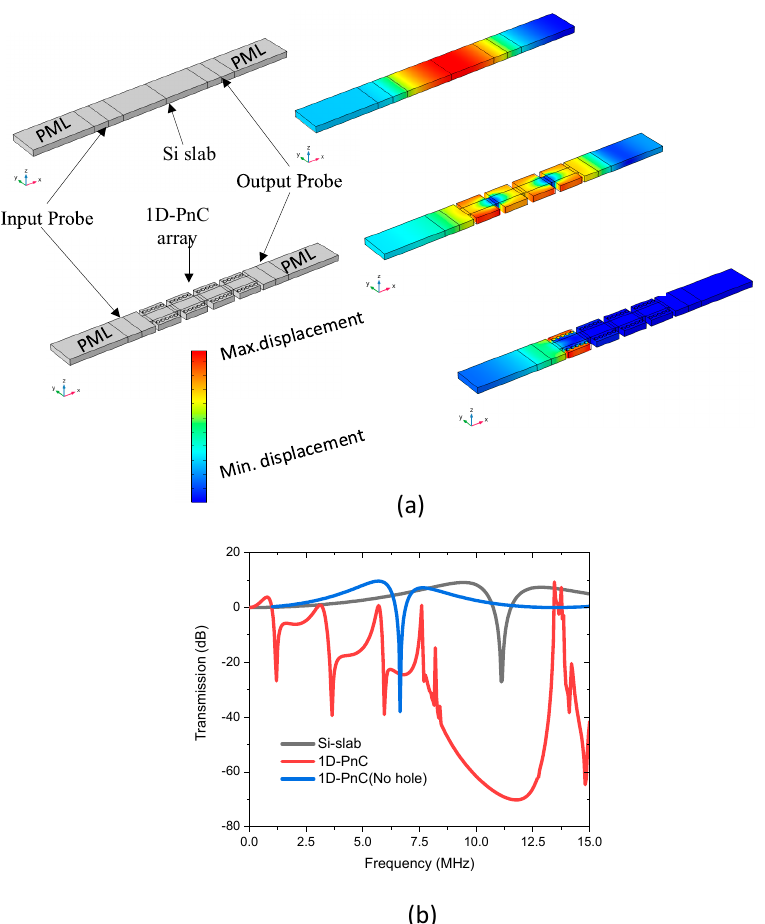
Figure 3. Illustration of transmission characteristics of the proposed 1D-PnC ( a ) delay lines set up to test the transmission of 1D-PnC taking the Si-slab based delay line and a 1D-PnC without hole as a control device. The mode shapes are taken at 10 MHz; ( b ) Transmission (dB) of the delay line made-up of 1D-PnC with and without scatterer holes in comparison with the Control Si slab based delay line.